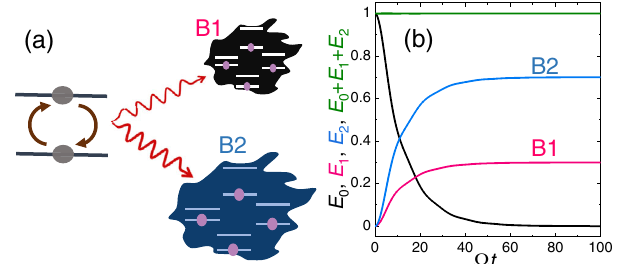
FIG. 4. Decay of the qubit to two uncoupled baths. (a) Scheme of the qubit and two baths B 1 and B 2 presented. (b) Results of solution of the Schrödinger equation for a qubit coupled to N ¼ 10 6 bath oscillators of which N 1 ¼ 3 × 10 5 are in B 1 and N 2 ¼ 7 × 10 5 in B 2 . The overall decay rate to the two baths is Γ 0 ¼ 0 . 084 Ω . We use Δ ω ¼ Ω in both baths. The descending line shows the expectation value of energy of the qubit, E 0 ¼ ℏ Ω j C 0 ð t Þj 2 , and the two rising lines E 1 ¼ P P N 1 N 2 ℏ ω C ℏ ω C t Þj 2 and E 2 ¼ t Þj 2 , the expecta- i j i; 1 ð i j i; 2 ð i ¼ 1 i ¼ 1 tion values of energy injected to baths B 1 and B 2 . The horizontal line at top demonstrates energy conservation over the whole time of decay, i.e., E 0 þ E 1 þ E 2 ¼ ℏ Ω